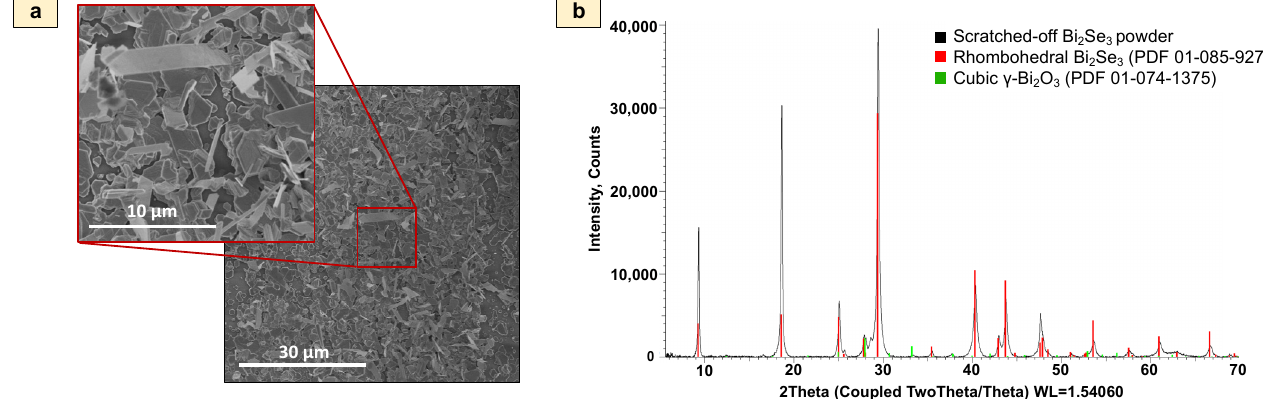
Figure 1. a —SEM image of Bi 2 Se 3 thin films on the glass substrate, b —XRD pattern of Bi 2 Se 3 powder obtained by scratching the as-grown thin film off the substrate.